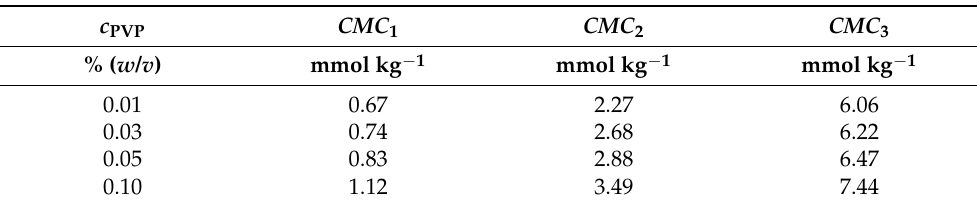
Table 2. The CMC values of CPC + PVP assembly in H 2 O having different concentrations of PVP at 303.15